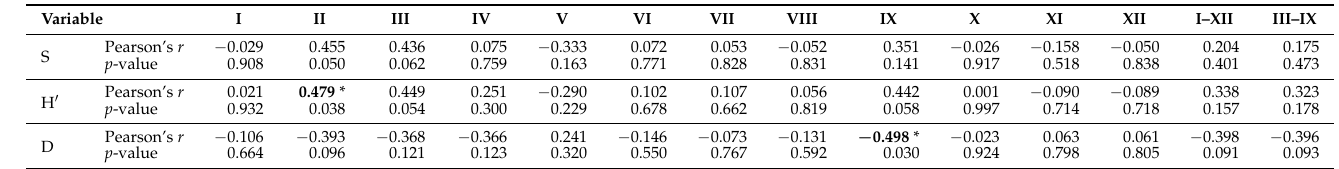
Table 1. Correlations between the averages of the temperature (I–XII) and species biodiversity (S, H’ and D) in ex-arable grassland from Gr ă dinari (period 2003–2021).